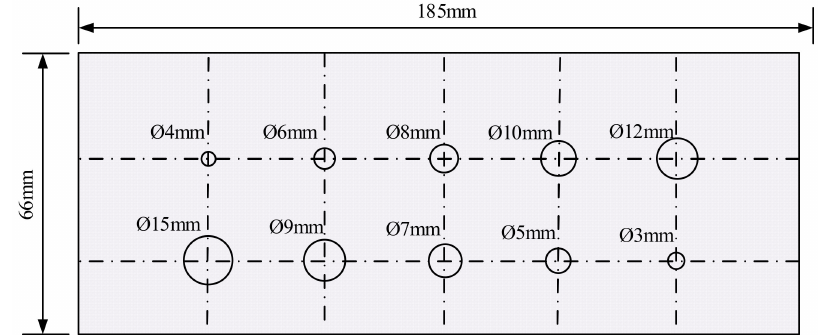
Figure 5. Honeycomb sandwich composite sample and defects